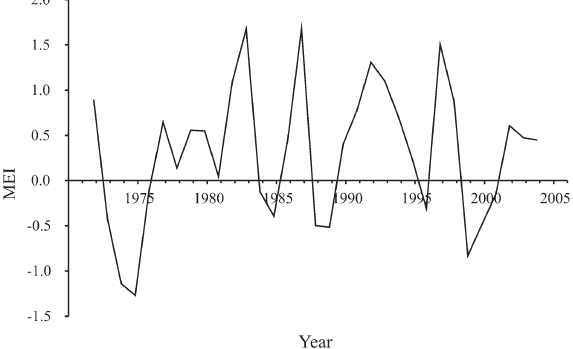
Fig . 3. – Multivariate enso index (Mei) in the area of Magdalena Bay for the period 1972-2004 (annual averages) (data taken from national oceanographic and atmospheric administration (noaa)